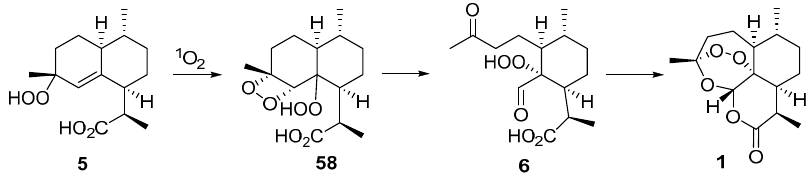
Scheme 13. The mechanistic possibilities for the conversion of artemisinic acid into artemisinin.